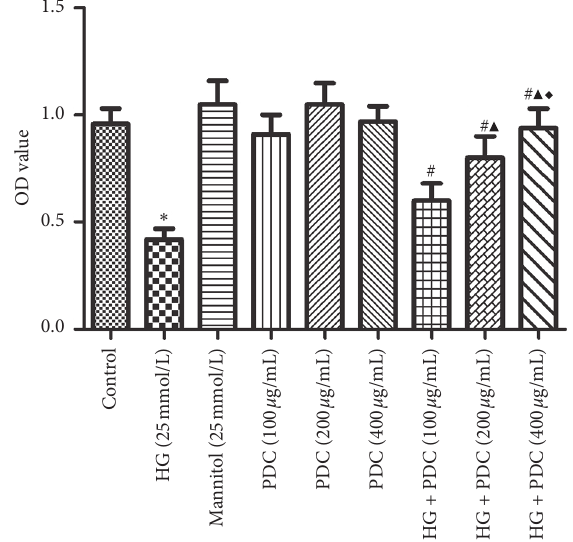
Figure 1: Effects of high glucose concentration and PDC on the viability of the HSF cells. HSF cells were incubated at high glucose concentration (25 mmol/L) or PDC (100, 200, and 400 μ g/mL) for 48h. The MTTassay was used to detect the cell viability. All the data were expressed as x ± S ( n � 3). ∗ P < 0 . 05, compared with the control group; # P < 0 . 05, compared with the high-glucose group; ▲ P < 0 . 05, compared with the high-glucose + Dendrobium poly- saccharide (100 μ g/mL) group; ◆ P < 0 . 05, compared with the high- glucose+ Dendrobium polysaccharide (200 μ g/mL)